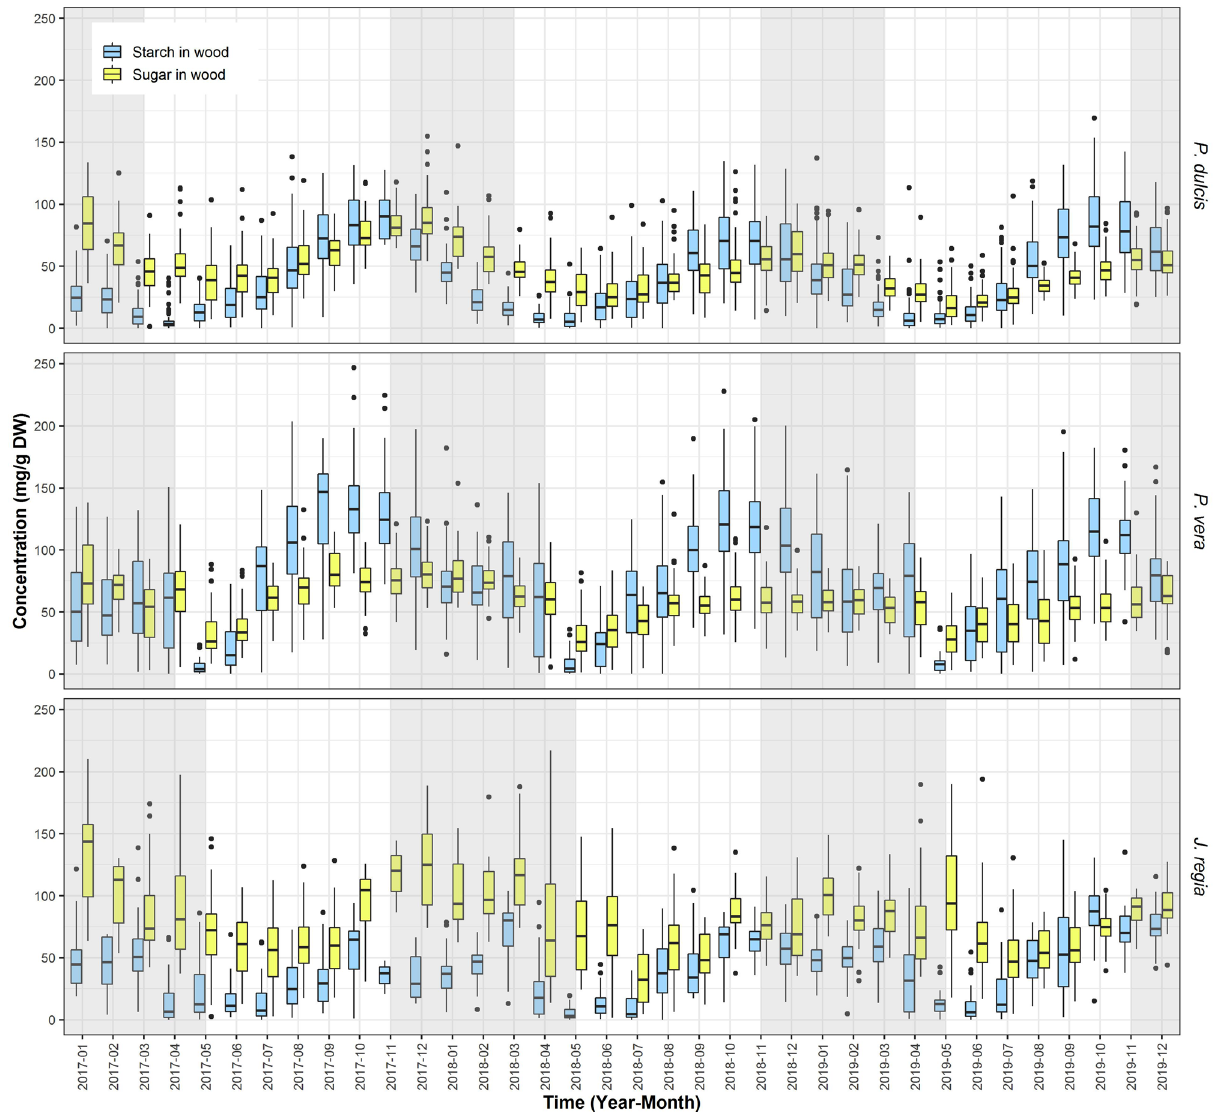
Figure 5. Starch and sugar in wood. Average concentration of starch (blue) and sugar (yellow) in wood from all sites for P. dulcis , P. vera and J. regia from January 2017 to December 2019. The upper whisker extends from the hinge to the largest value no further than 1.5*IQR from the hinge (where IQR is the inter-quartile range, or distance between the first and third quartiles). The lower whisker extends from the hinge to the smallest value at most 1.5*IQR of the hinge. Grey shading reflects the dormancy period of each